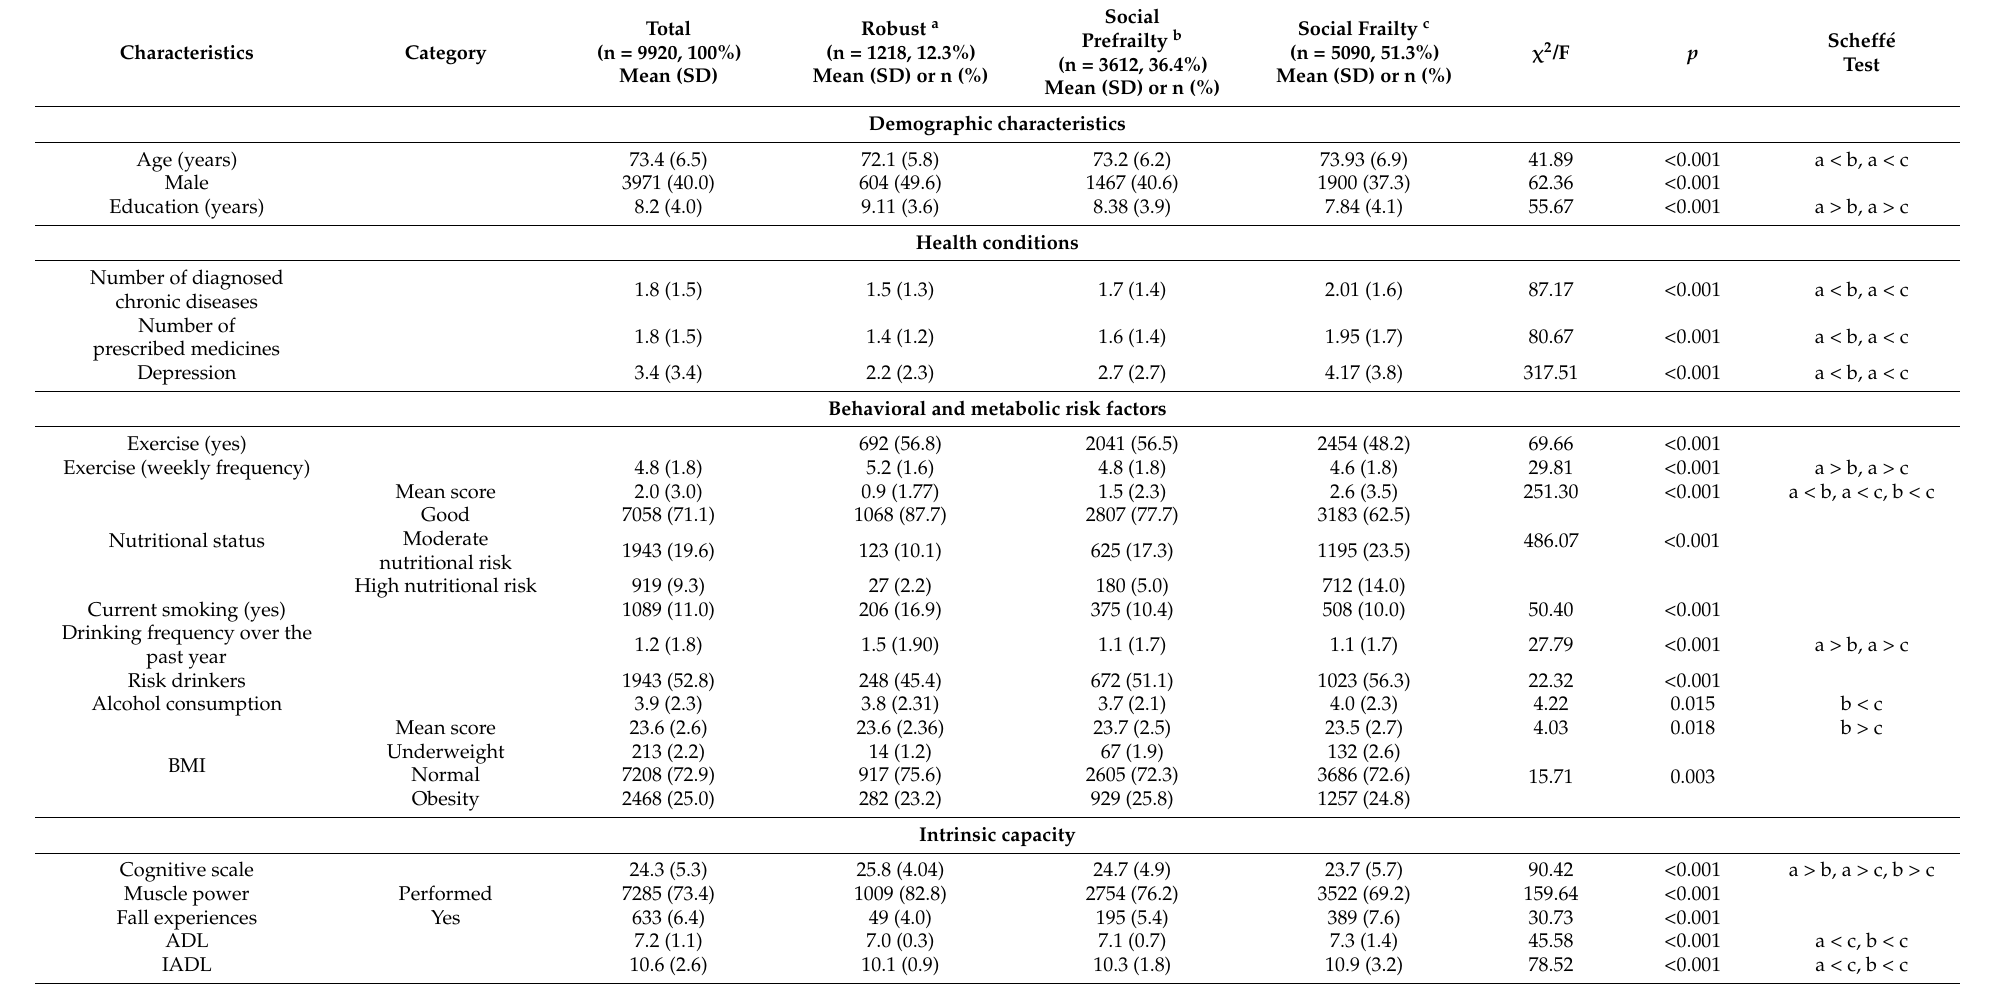
Table 1. Differences in health conditions, behavioral and metabolic risk factors, and intrinsic capacity of participants in the robust, social prefrailty, and social frailty groups (N =